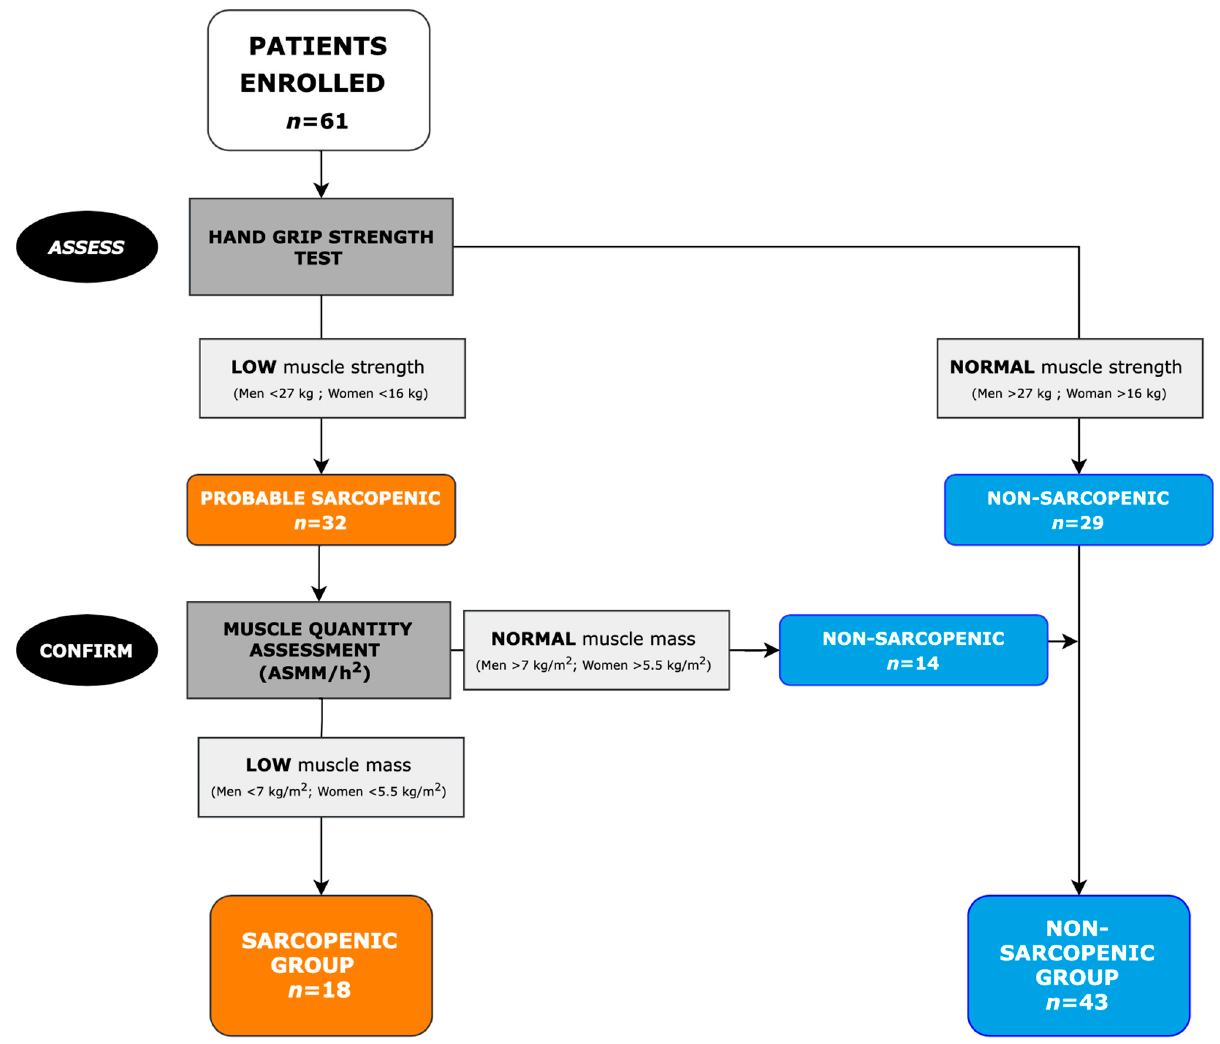
Figure 1. EWGSOP2 algorithm for case finding and diagnosis of sarcopenia at baseline in the sample group. Patients enrolled ( n = 61) were assessed by handgrip test and the diagnosis in patients with probable sarcopenia ( n = 32) was confirmed by muscle-quantity assessment using bioelectrical impedance analysis (BIA), identifying a Sarcopenic Group (SG) of 18 subjects and a Non-Sarcopenic Group (NSG) of 43 subjects.